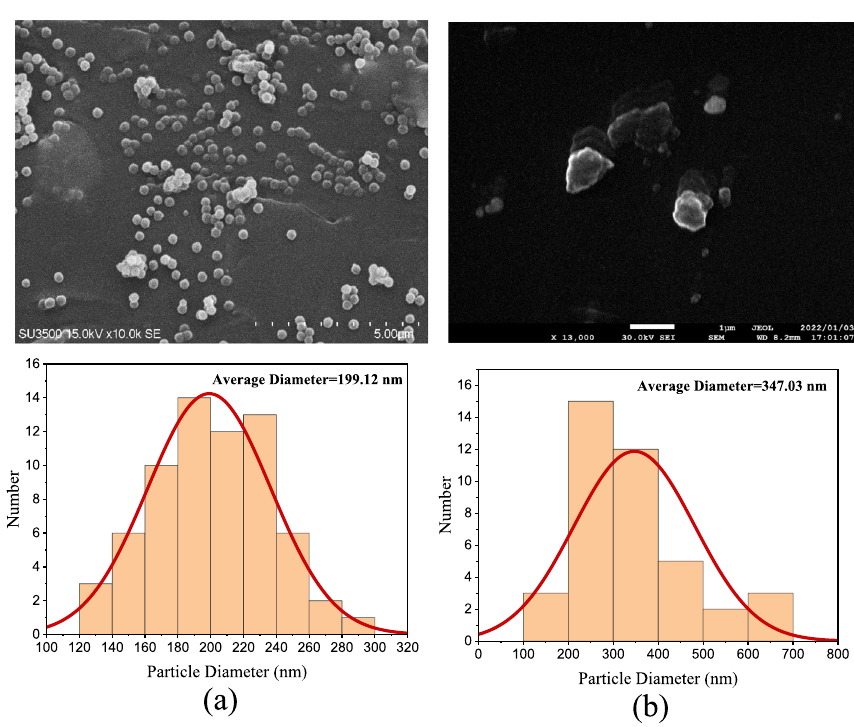
Figure 5. The SEM images and size distribution of the Au NPs embedded into the fabricated lenses with an incubation time of ( a ) 12 h, and ( b ) 72